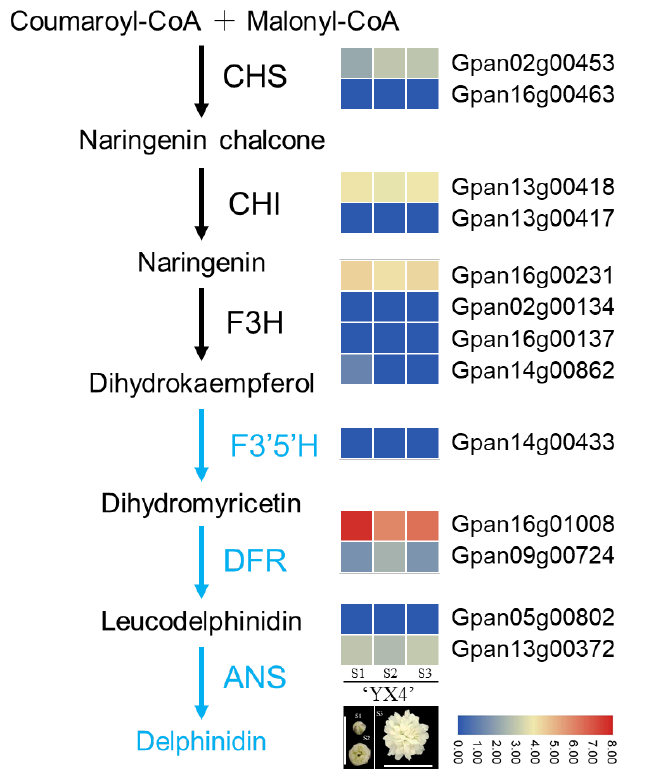
Figure 1. The delphinidin biosynthesis pathway in G. paniculata . Heat map of the expression of delphinidin biosynthesis pathway genes was constructed using TBtools. The S1, S2, and S3 are flower bud stage (S1), semi-open stage (S2), and fully open stage (S3), respectively. The scale bar is 1 cm. Abbreviations include CHS: chalcone synthase; CHI: chalcone isomerase; F3H: flavanone 3-hydroxylase; F 3′5′ H: flavonoid 3′ , 5′ -hydroxylase; DFR: dihydroflavonol 4-reductase; ANS: anthocyanidin synthase.